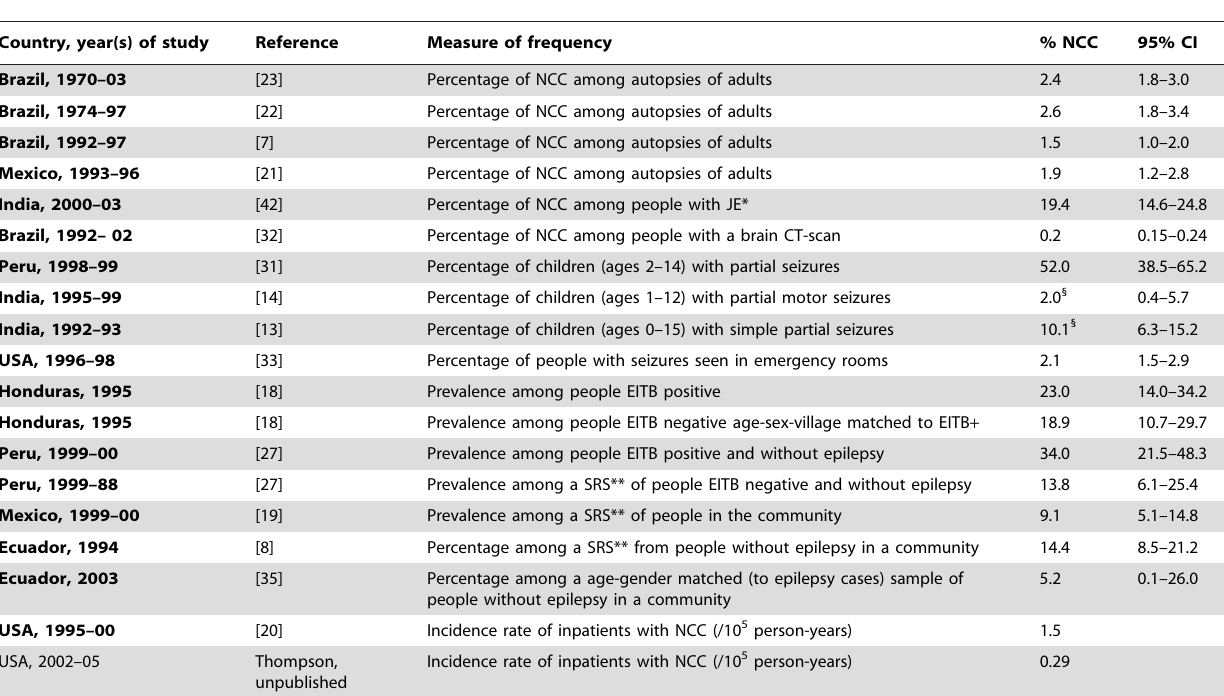
Table 3. Frequency* of NCC (95% CI) identified in the systematic